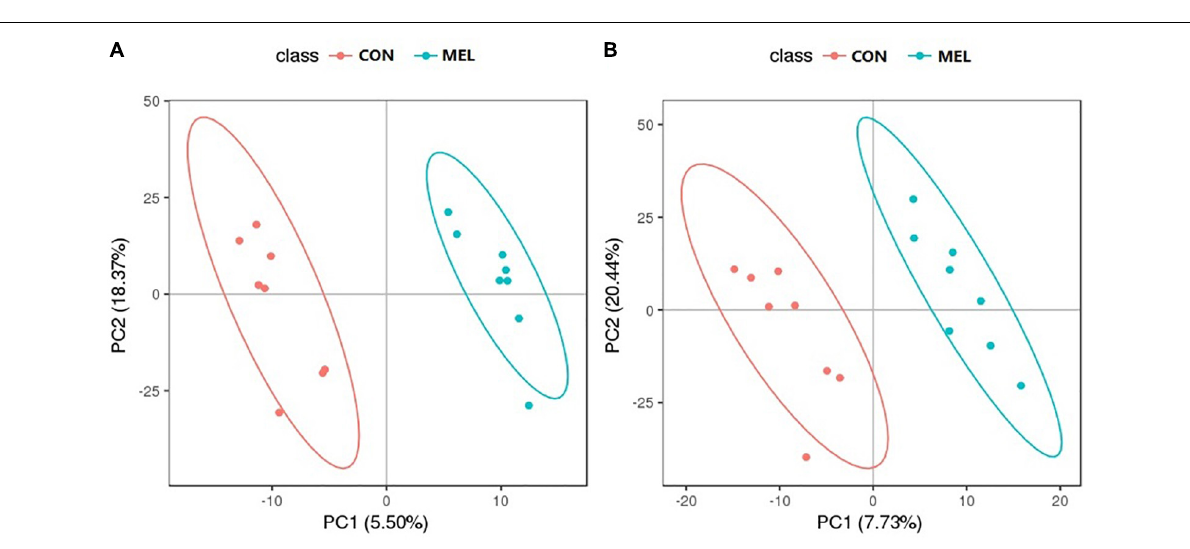
FIGURE 3 | The partial least square discriminant analysis (PLS-DA) scores plot of muscle metabolites from the control (CON) and melatonin treated (MEL) groups in the positive ion (A) and negative ion (B) scan modes. The abscissa and ordinate represent the first principal component (PC1) and the second principal component (PC2)